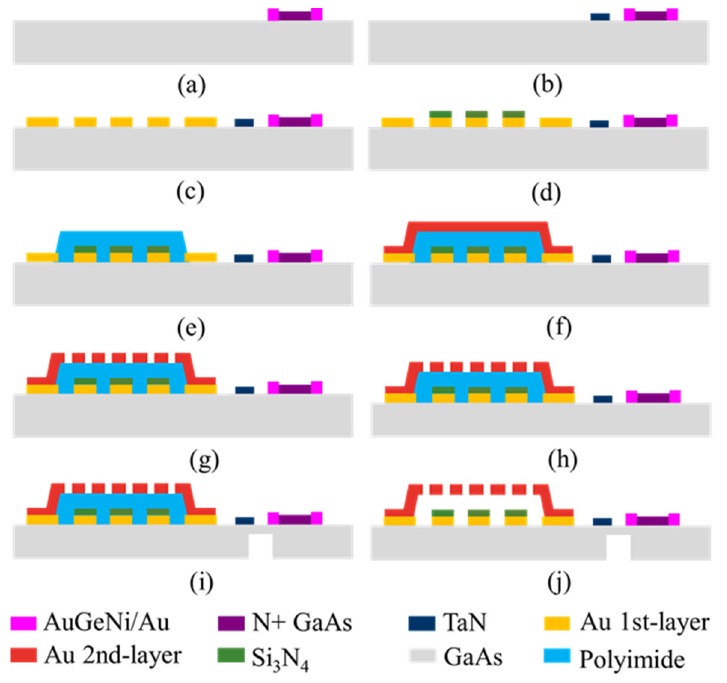
Figure 5. ( a – j ) Process steps of the cascaded MEMS amplitude demodulator.